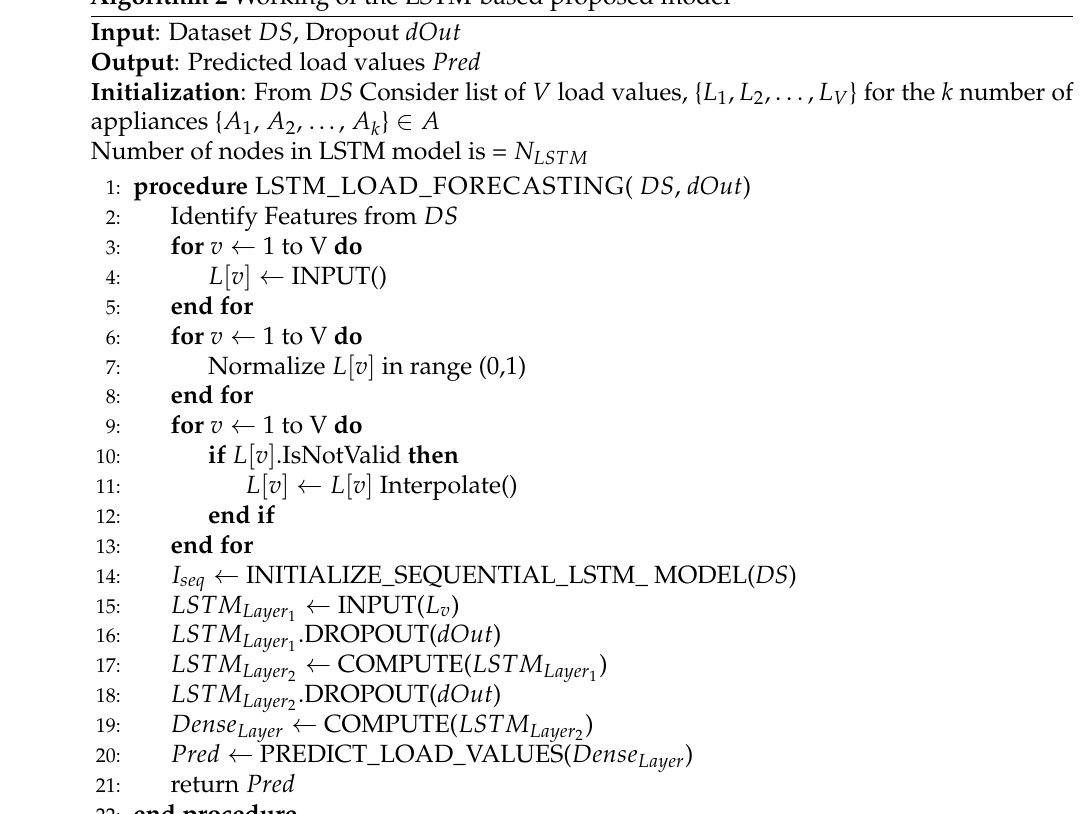
Algorithm 2 Working of the LSTM-based proposed model